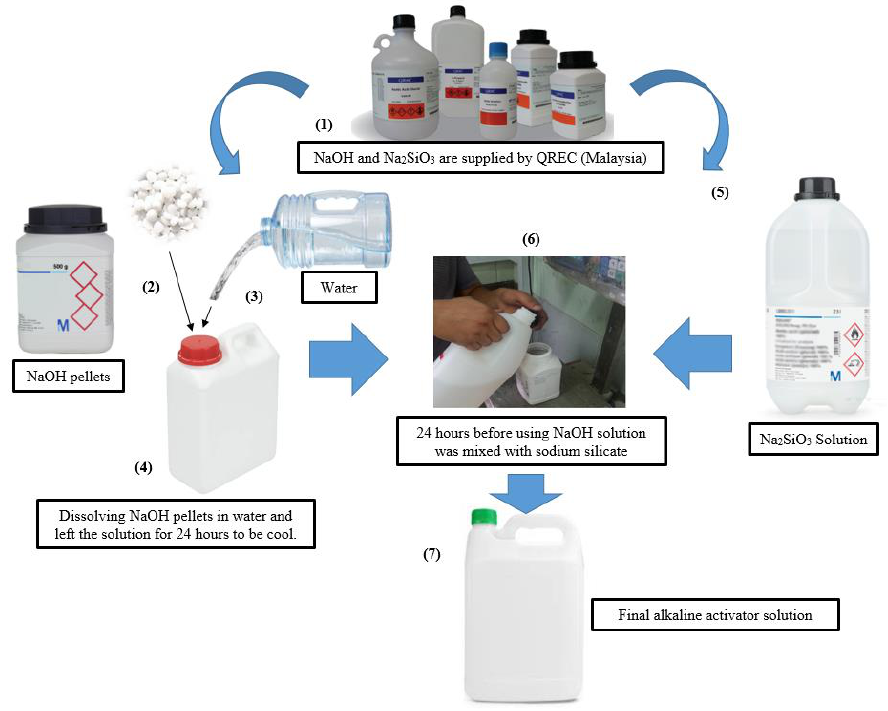
Figure 4. Stages of preparation of two-part alkaline activator solution.